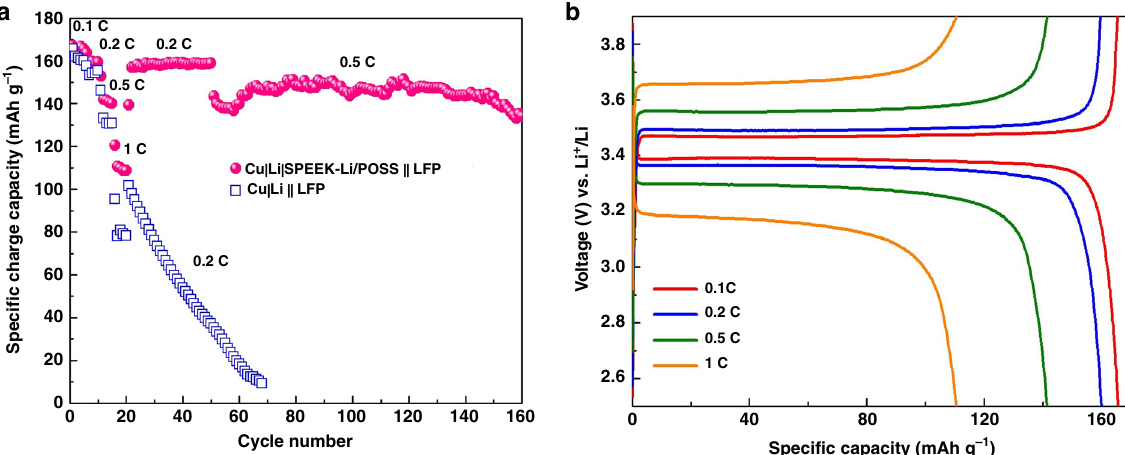
Fig. 7 Full-cell electrochemical characterizations with the carbonate-based electrolyte. a Comparison in rate and cycle performance between full cells with (Cu|Li|SPEEK-Li/POSS||LFP; red) and without (Cu|Li||LFP; blue) a SPEEK-Li/POSS coating on their Li thin- fi lm anodes. The cathode is LiFePO 4 (1.85 mAh cm − 2 ) and the Li thin- fi lm anode is pre-coated on Cu (loading = 3 mAh cm − 2 ). 1 C corresponds to 170 mAh g − 1 based on LFP in cathode. b Corresponding voltage pro fi les of the Cu|Li|SPEEK-Li/POSS||LFP cell at 0.1, 0.2, 0.5, and 1 C